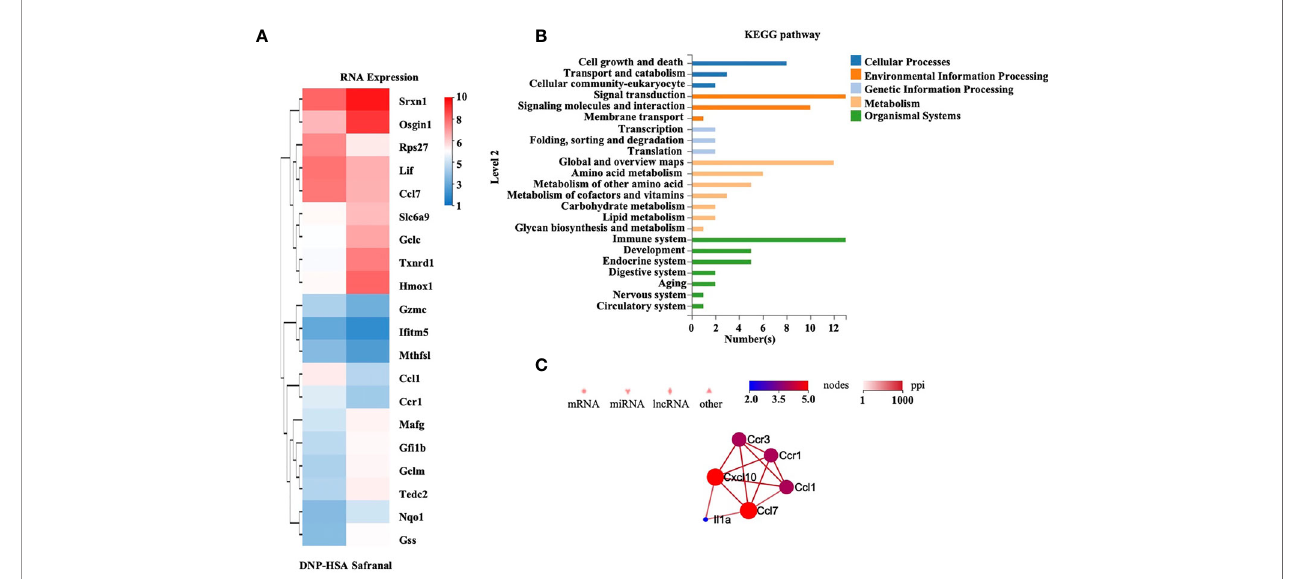
FIGURE 5 | RNA-sequencing of safranal and DNP-HSA treated BMMCs. BMMCs were treated with safranal before stimulating with DNP-HSA. (A) Heatmap of genes expression shows effect of safranal treated BMMC on representative differentially expressed genes comparing to DNP-HSA treated. False Discovery Rate (FDR) ≤ 0.05 and |Log2Ratio| ≥ 1. (B) KEGG pathway database analysis found 13 differentially expressed genes that were related to the immune systems. (C) The protein interactions of these genes were evaluated, Ccl7 and Cxcl10 were found to be most related among the differentially expressed